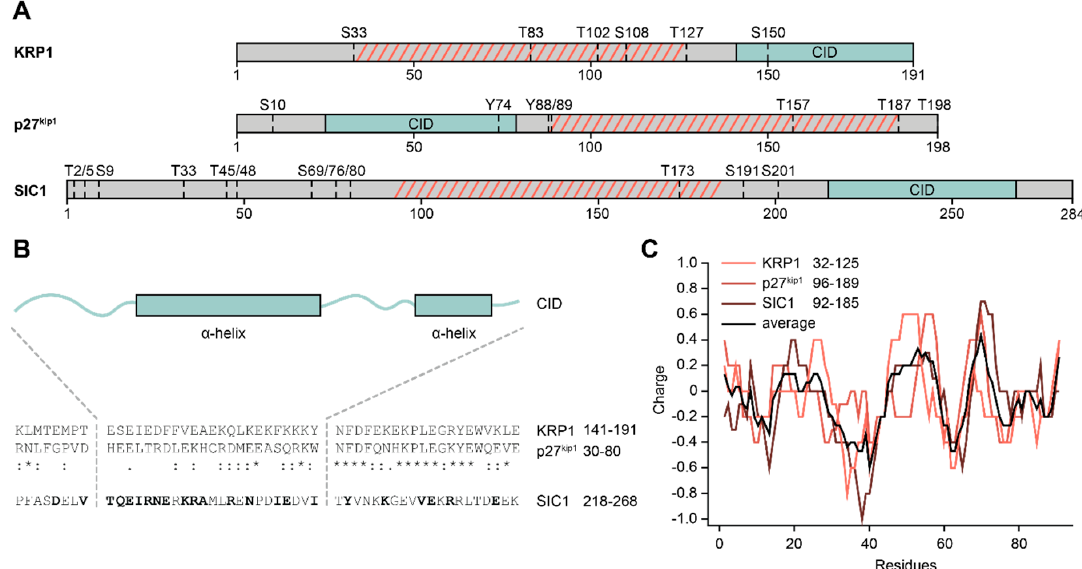
Figure 4. Features of cyclin-dependent kinase inhibitors (CKIs). ( A ) Overview of general CKI architecture across organisms. Arabidopsis KRP1, human p27 kip1 , and yeast SIC1 all share a large intrinsically disordered region (grey) that shows no sequence conservation. A sequentially conserved inhibitory domain (CID; green) is located at different positions in the proteins. Dotted lines denote known (p27 kip1 , SIC1) or predicted (KRP1; NetPhos 3.1 score > 0.9) phosphorylation sites in the IDR. ( B ) Sequential comparison of the conserved CID. KRP1 and p27 kip1 are sequentially conserved, while SIC1 only shows similar amino acids (bold letters) in several positions to either protein. Two alpha helices (boxes) comprise the binding domain of the CIDs, as shown by the crystal structure of p27 kip1 , modelling of SIC1, or prediction with JPRED for KRP1. ( C ) All three CKIs show conserved, charge-based features in the IDR region between important phosphorylation sites (highlighted by hatched, red lines in ( A ).